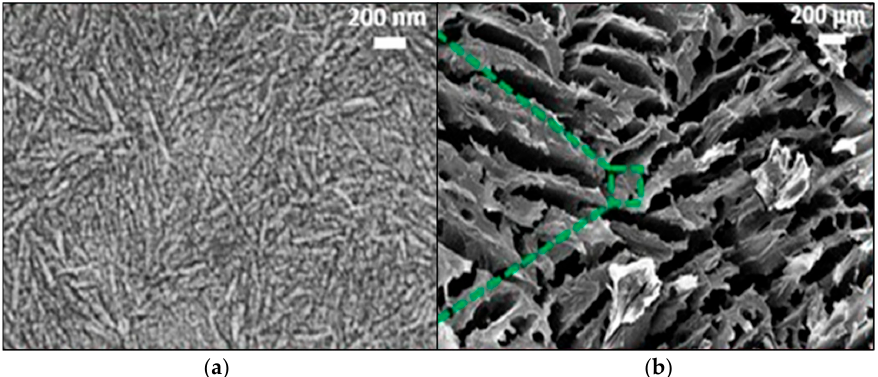
Figure 8. Scanning electron microscopy (SEM) image for ( a ) aerogel structure and ( b ) cellulose nanocrystal (CNC) constituted of the aerogels